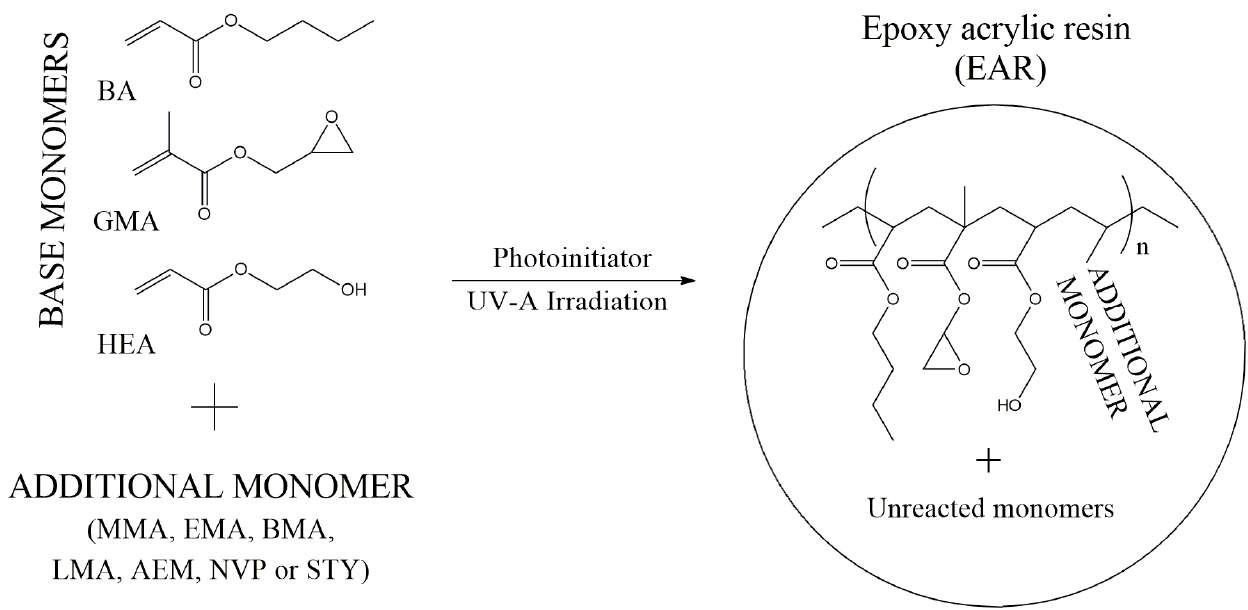
Figure 1. Preparation of epoxy acrylic resins via free-radical photopolymerization process. Copolymerizations were realized at an initial temperature of 21 ± 2 ◦ C, controlled with water-cooling. The temperature of the reaction mixture was monitored during the